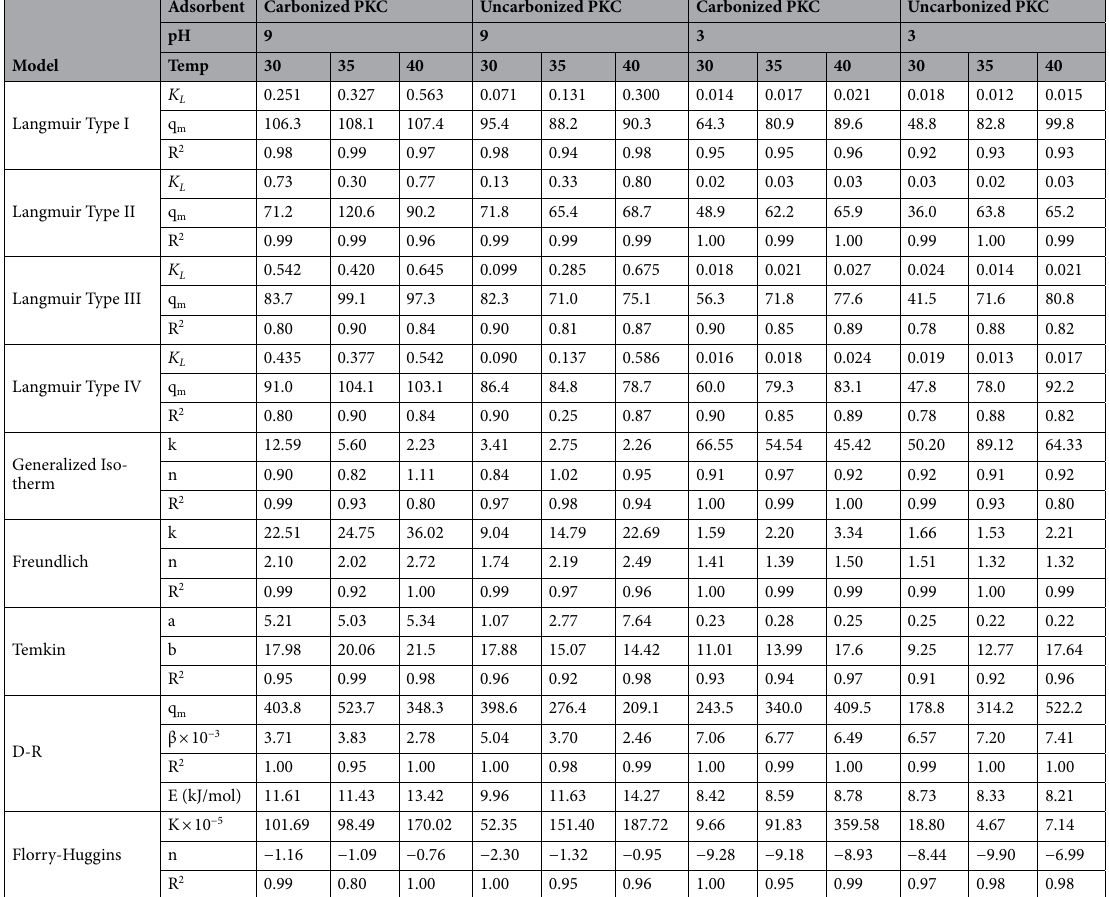
Table 2. Sorption isotherm parameters for linear